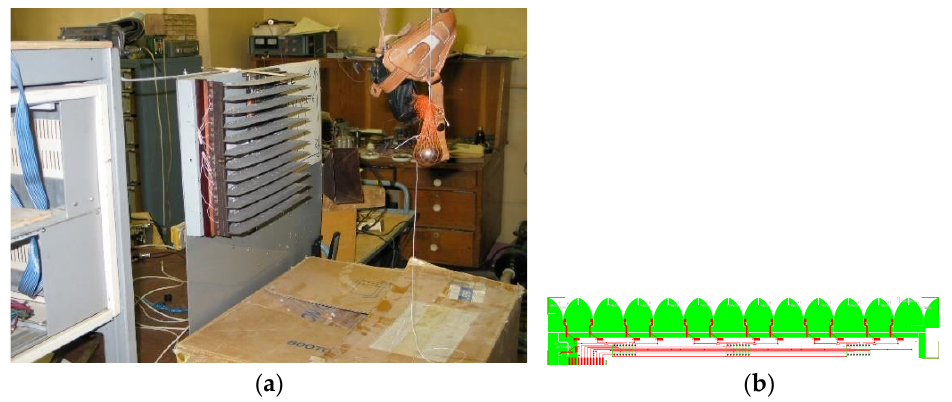
Figure 2. Holographic antenna array ( a ) composed of twelve 12-element Vivaldi antenna lines ( b ). Experimental tests of this device were carried out at the EPOS department of IZMIRAN (A.E. Reznikov, V.V. Kopeikin, S.A. Annakuliev) and later in St. Petersburg at JSC Jupiter-Z (N.A. Fedorov, N.E. Podozerov), together with A.V. Popov and graduate students V.A.